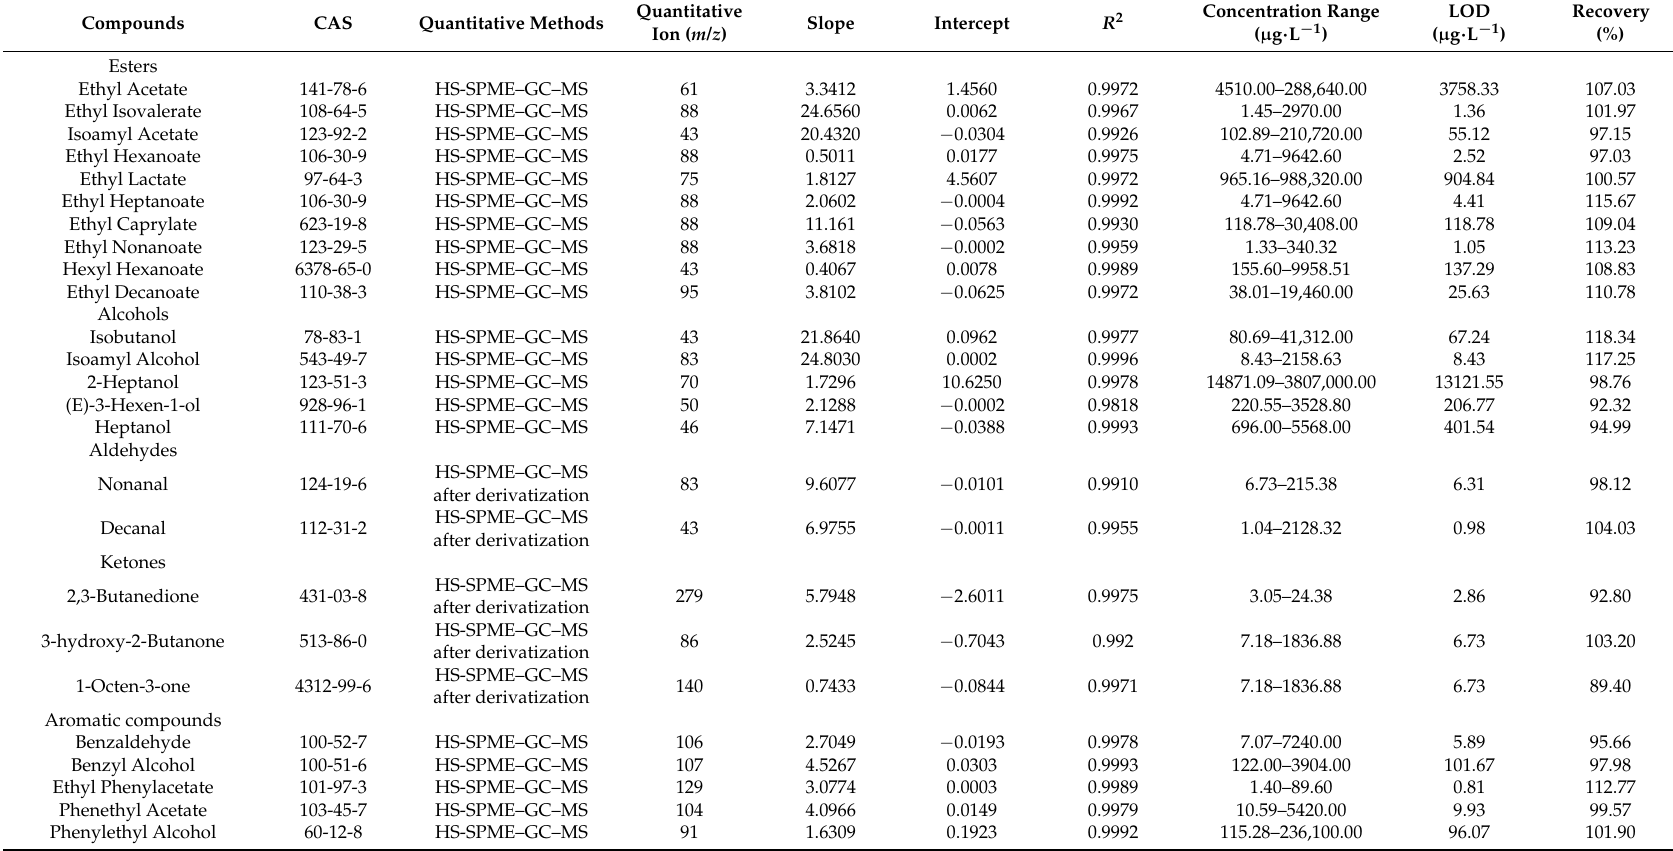
Table 2. Chemical standards, quantitative ions, and calibrated intervals for Cabernet Sauvignon wines of Loess